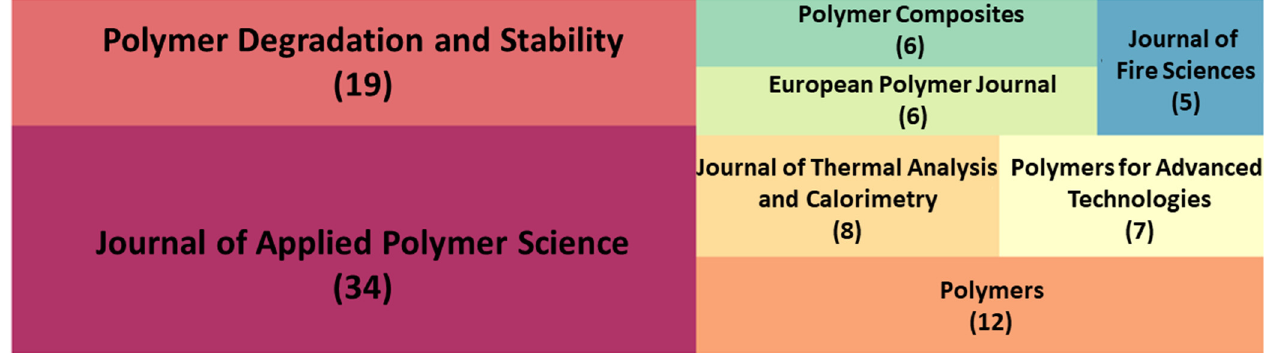
Figure 3. Top 8 journals that published articles on flame-retardant RPUF.